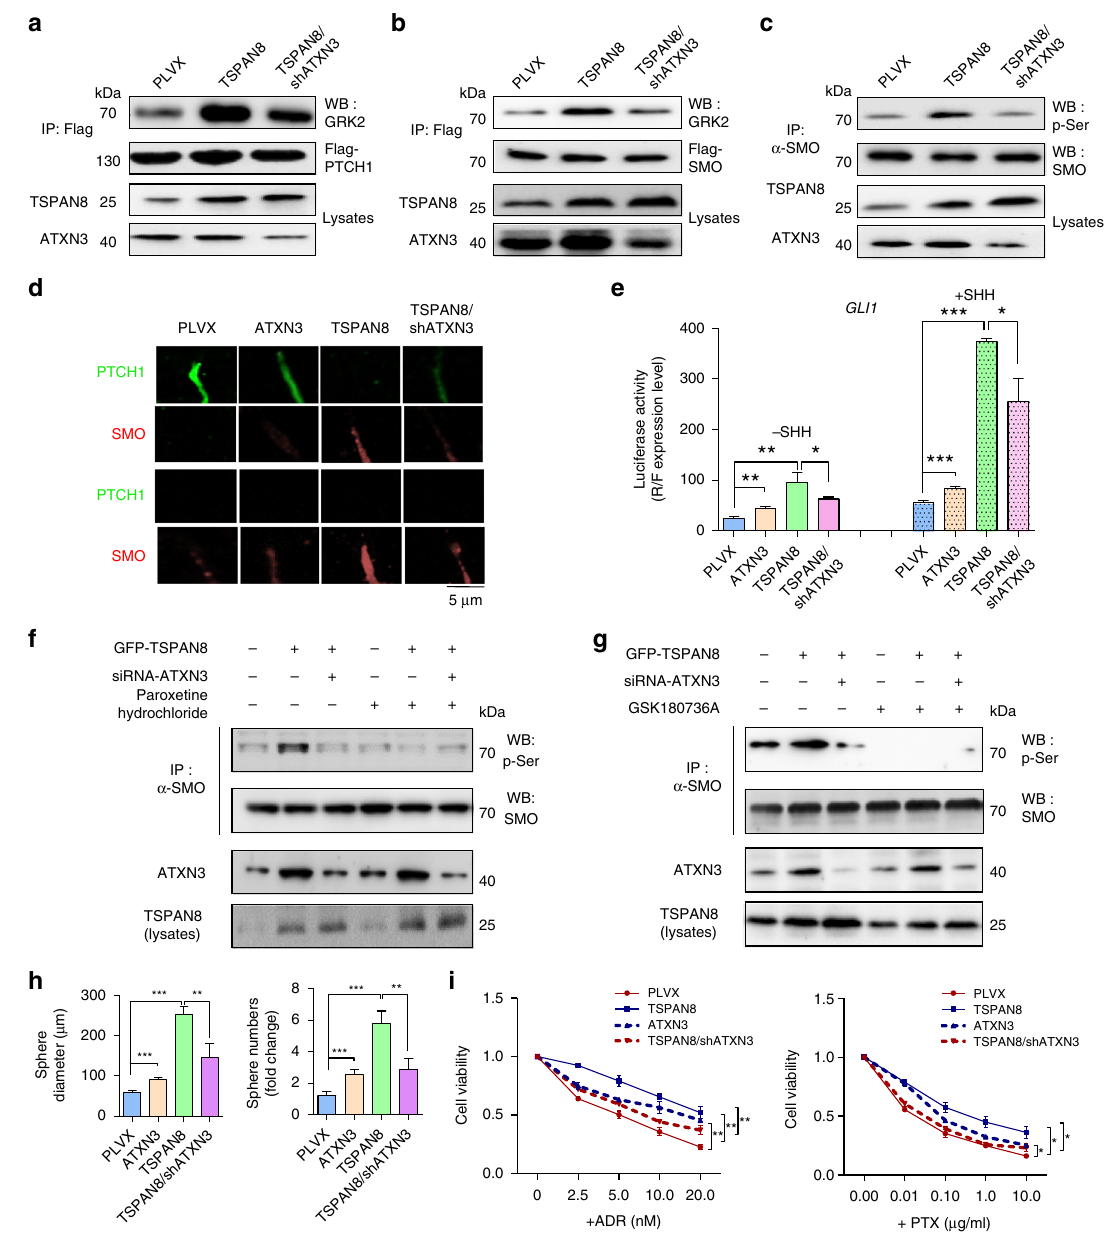
Fig. 5 TSPAN8 promotes SHH-induced SMO phosphorylation. a , b Flag-PTCH1 ( a ) or Flag-SMO ( b ) was immunoprecipitated from MCF7 cells with or without TSPAN8 overexpression in the presence or absence of ATXN3 shRNA. Cells were treated with 100 ng/ml SHH for 6 h. Immunoblotting analyses were performed with the indicated antibodies. PLVX, lentiviral stable transfection plasmid pLVX-HA-IRES-Puro. c Endogenous SMO was immunoprecipitated from MCF7 cells with or without TSPAN8 overexpression in the presence or absence of ATXN3 shRNA. Cells were treated with 100 ng/ml SHH for 6 h. Immunoblotting analyses were performed with the indicated antibodies. P-Ser, phosphorylated serine. d MCF7 cells with or without overexpressing ATXN3 or TSPAN8 or MCF7 cells with overexpressing TSPAN8 and ATXN3 shRNA were left untreated or treated with 100 ng/ml SHH. Immuno fl uorescent studies were performed with the indicated antibodies. e MCF7 cells with or without overexpressing ATXN3 or TSPAN8 or MCF7 cells with overexpressing TSPAN8 and ATXN3 shRNA were transfected with a GLI1 promoter – luciferase reporter plasmid. These cells were left untreated (left) or treated (right) with 100 ng/ml SHH. Luciferase activity was measured and normalized to Renilla luciferase activity ( n = 3 per group). Two-tailed unpaired Student ’ s t test was performed. * P < 0.05, ** P < 0.01, and *** P < 0.001. f , g MCF7 cells with or without expressing GFP- TSPAN8 in the presence or absence of ATXN3 siRNA expression were treated with 20 μ M Paroxetine hydrochloride ( f ) or 2 μ M GSK180736A ( g ) together with 100 ng/ml SHH for 6 h. Cellular extracts were immunoprecipitated with anti-SMO antibody, then immunoblotting analyses tested the serine-phosphorylation expression level. h Histograms show the mean numbers and diameters of spheres formed by MCF7 cells expressing the indicated proteins and ATXN3 shRNA. i MCF7 cells expressing the indicated proteins and ATXN3 shRNA were treated with ADR (left) or PTX (right) with the different concentrations for 24 h. The cell viabilities were determined. Cell numbers with no drug was used as control ( n = 3 per group). Two-tailed unpaired Student ’ s t test was performed. * P < 0.05, ** P < 0.01, and *** P <